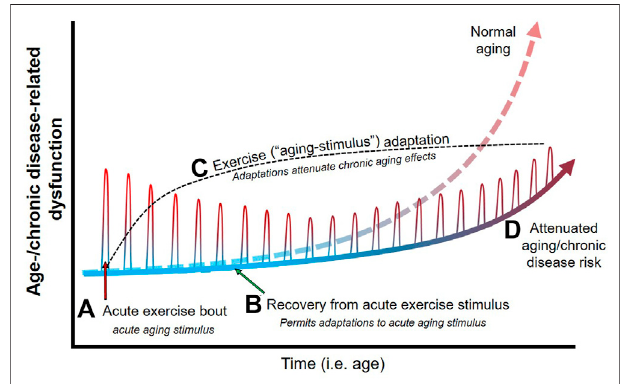
FIGURE 2 | Theoretical effects of physical exercise as an aging stimulus on age-/chronic disease-related physiological dysfunction. Age-related dysfunction (e.g., cardiovascular, metabolic, muscular) generally increases steeply around middle-age into older age, and results in an increase in chronic disease risk. An acute bout of exercise (A) acts as an aging stimulus and elicits responses during exercise that mimic that of age-related dysfunction (e.g., increased large artery stiffness, in fl ammation, etc.). Cessation of exercise (i.e., removal of the acute aging stimulus) and proper recovery between exercise bouts/stimuli (B) permits adaptations (C) that servetoreducethephysiologicalstressduringsuccessiveexercise(i.e.,aging) bouts. Since acute exercise elicits physiological responses that parallel aging, exerciseadaptations essentiallypreparethebodytoendureless physiological stress and dysfunction when exposed to the effects of aging over time. As such,regularexposuretotransientagingstimuli(i.e.,regularphysicalexercise) elicits physiological adaptations that attenuate age-/chronic disease-related dysfunction (D) , and thus attenuates many of the detrimental physiological effects of age and protects against chronic disease